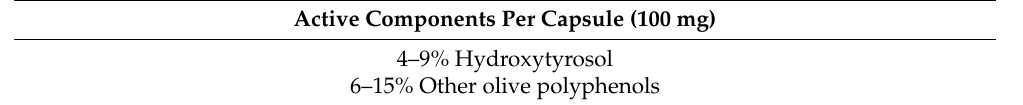
Table 1. Analytical specifications of the dietary supplement—namely SelectSIEVE ® OptiChol—used in the clinical